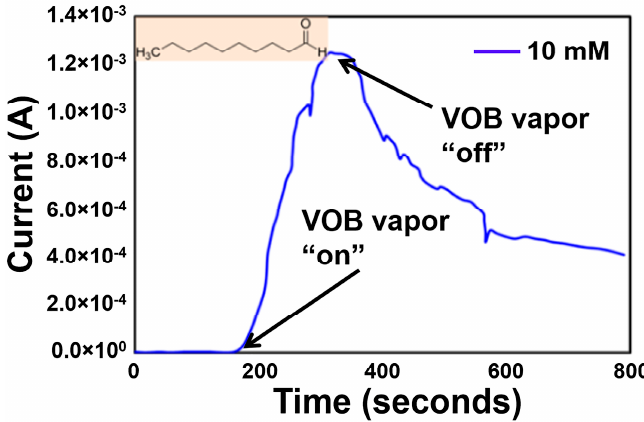
Figure 8. Sensor response of Ni-TNA to vapors of decanal at 10 mM concertation in ethanol, arrows indicate the point when the sensor exposure to the VOB was started and removed.